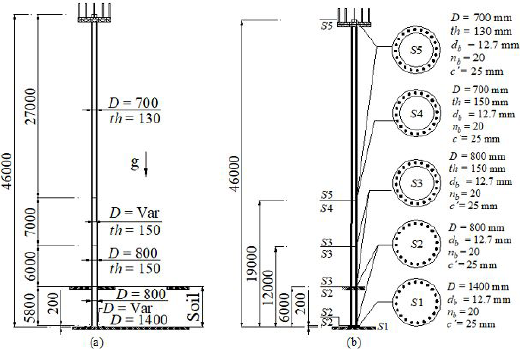
Figure 3. System analyzed (all measures in “mm”): (a) details of geometry; (b) heights and structural arrangement.